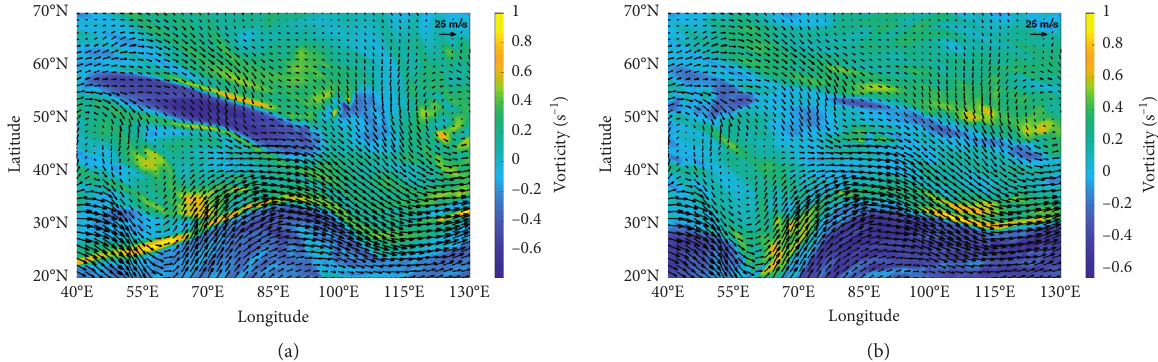
Figure 8: Initial velocity field of 200 hPa jet flow at (a) T � 60 h, (b) T � 124h (velocity visualized by vector plots and the background color contours visualize the vorticity